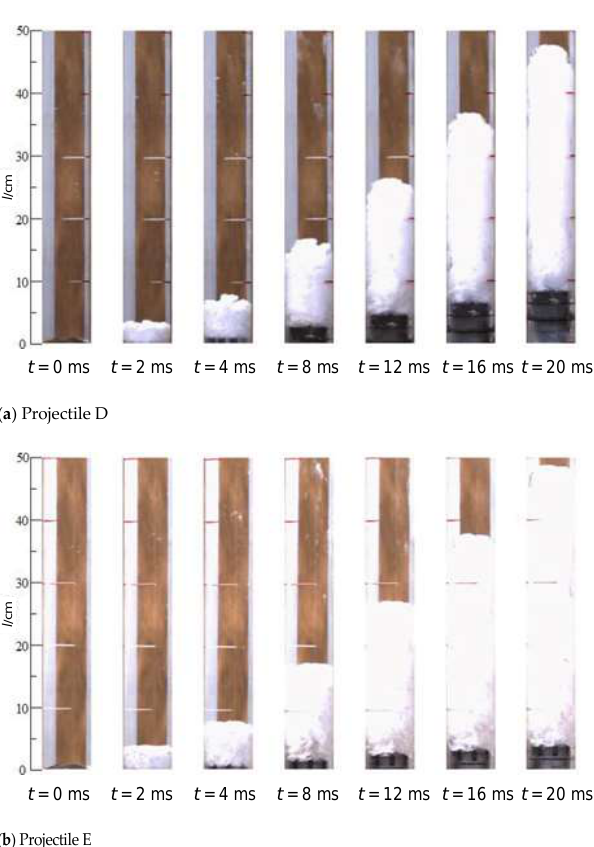
Figure 9. Sequence diagram of simulated launching process under different groove numbers ( p max = 9.9 MPa).